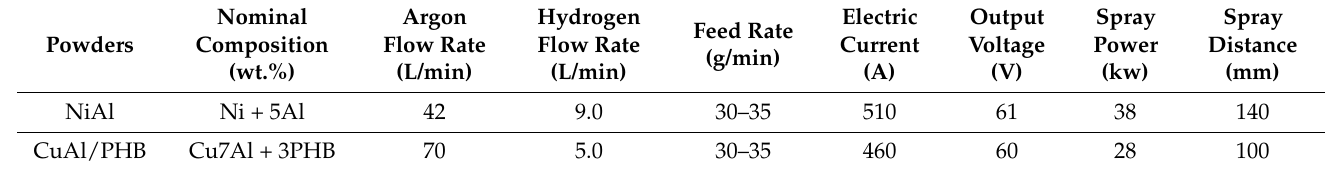
Table 1. Material composition and process parameters of atmospheric plasma spraying.